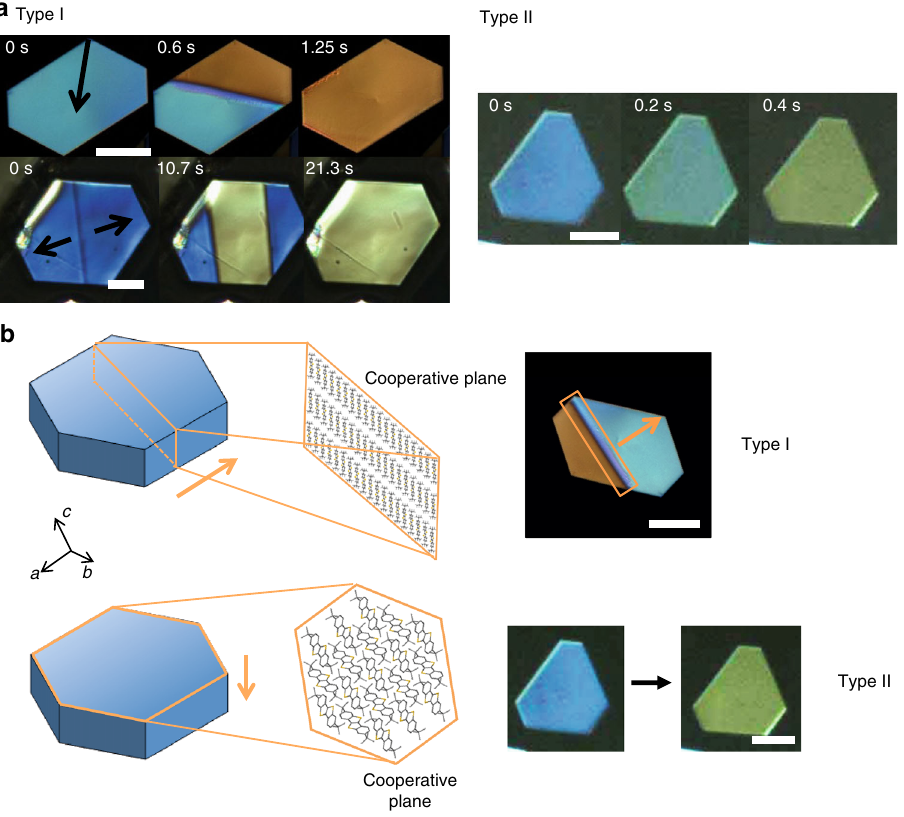
Fig. 1 Martensitic transition in ditBu-BTBT single crystals. a POM images of ditbu-BTBT single crystals displaying Types I and II transition from LT (blue) to HT (yellow). The arrows in Type I panel indicate direction of movement of the phase boundary line between LT and HT forms. Top and bottom scale bars correspond to 100 and 25 µ m, respectively. Type II transition exhibits a uniform change in birefringence across the entire crystal surface. Scale bar corresponds to 25 µ m. b Schematic of the cooperative molecular planes (enclosed molecules) involved in Type I and Type II transitions. The two types are differentiated in terms of the direction of phase boundary propagation. Top and bottom scale bars correspond to 100 and 25 µ m,